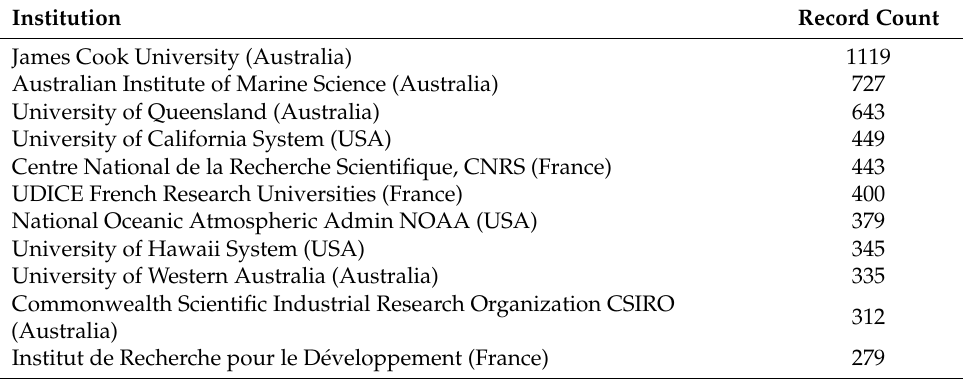
Table 1. Top 20 institutions in the field of coral reef and climate